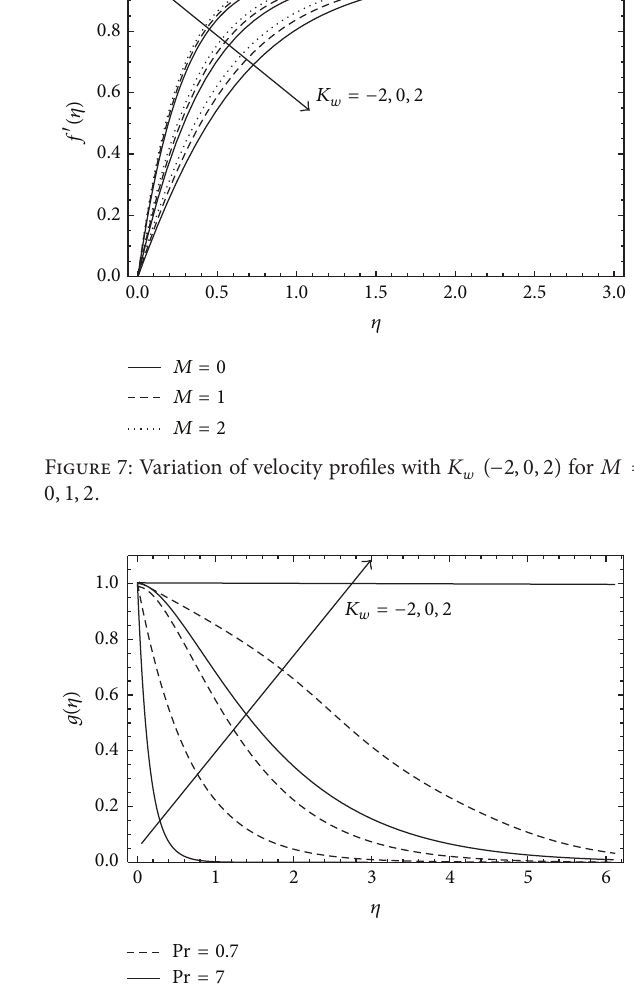
Figure 8: Variation of temperature profiles for 𝑀 = 1, Pr (= 0.7, 7), 𝑁 = 0 , and 𝐾 (= −2,0, 2) 𝑤